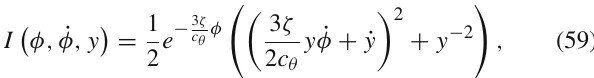
(cid:9) (cid:10) , 0 1 , dashed line is 2